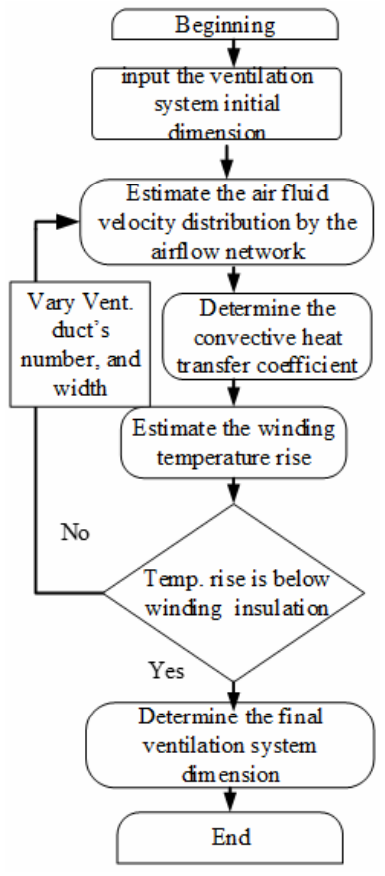
Figure 11. The overall stator axial ventilation optimization process.